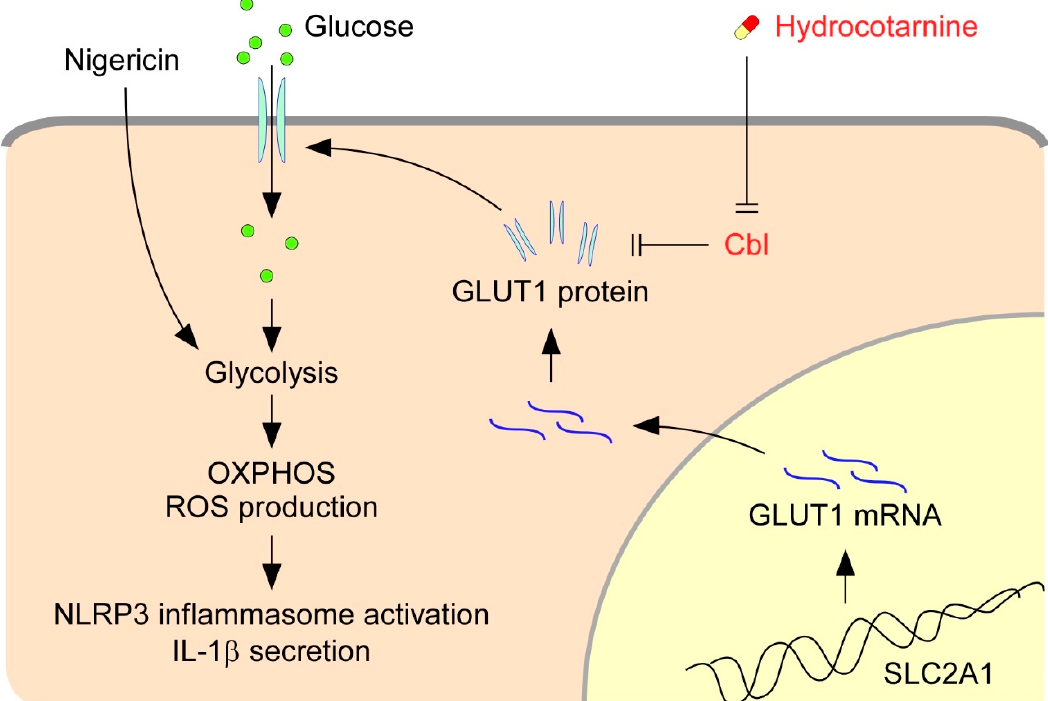
Figure 7. Model for the Cbl–GLUT1 axis-dependent negative regulation of NLRP3 inflammasomes. On the basis of our results, we proposed that Cbl reduces surface expression of GLUT1 protein and thereby contributes to suppression of the NLRP3 inflammasomes. GLUT1 protein encoded by the gene solute carrier family 2 member 1 (SLC2A1) is a major glucose transporter in macrophages that transports glucose from outside to inside cells. Intracellular glucose is an indispensable substrate for initiation of glycolysis. In response to stimulation of the NLRP3 agonist nigericin, glycolysis is activated and fuel oxidative phosphorylation (OXPHOS) activation occurs, which increases the generation of by-products from OXPHOS, known as cellular ROS, which then stimulate NLRP3 inflammasome activation and IL-1 β secretion. GLUT1 expression is reduced by Cbl through post-transcriptional regulation. Reduction of GLUT1 by Cbl inhibits the cellular glucose uptake, which thus dampens the NLRP3 inflammasomes. Importantly, inhibition of Cbl with hydrocotarnine can remove the restraints on GLUT1 expression and enhance NLRP3 inflammasome activation.